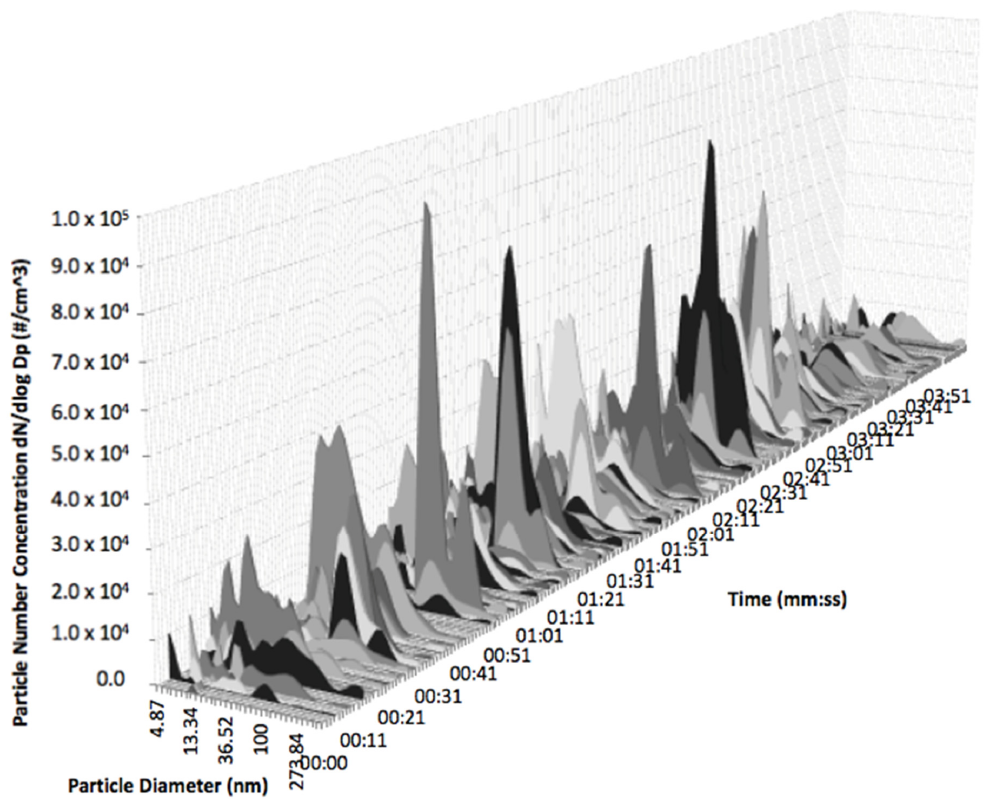
Figure 6. Particle size distribution recorded on the DMS50 during 4 minutes from the EP/CF/GO 0.1 wt.%